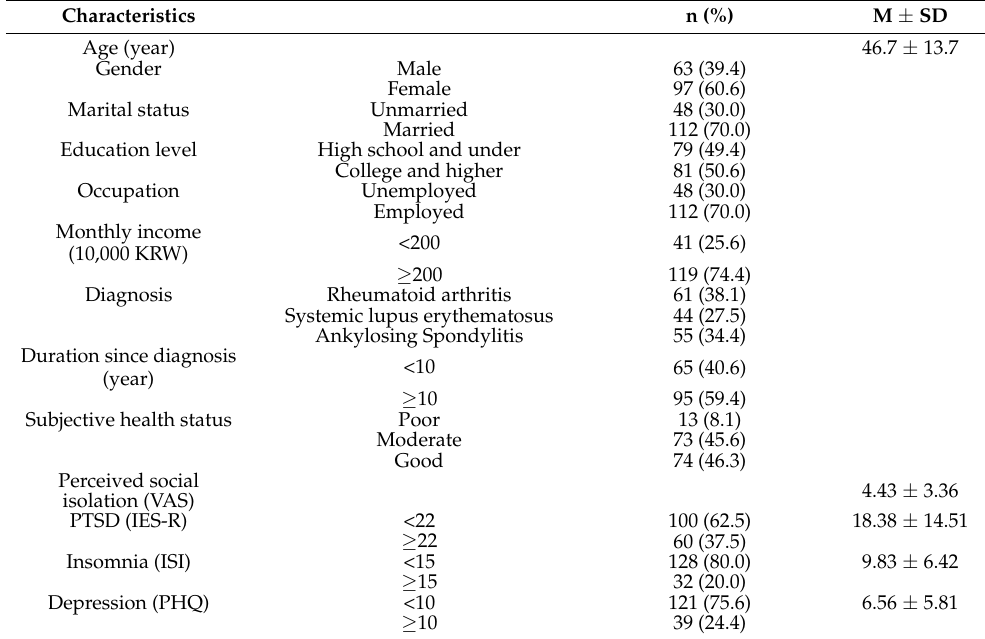
Table 1. General characteristics and research variables of participants ( N = 160).